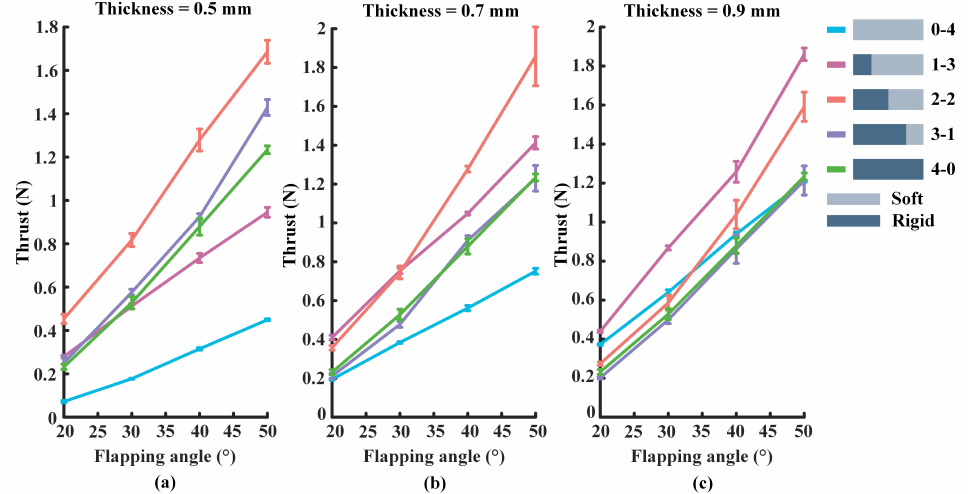
Figure 3. The thrust produced by the foil at the flapping frequency of 0.5 Hz: ( a ) The thickness of the flexible plate of the foil is set to 0.5 mm. ( b ) The thickness of the flexible plate is set to 0.7 mm. ( c ) The flexible plate’s thickness is 0.9